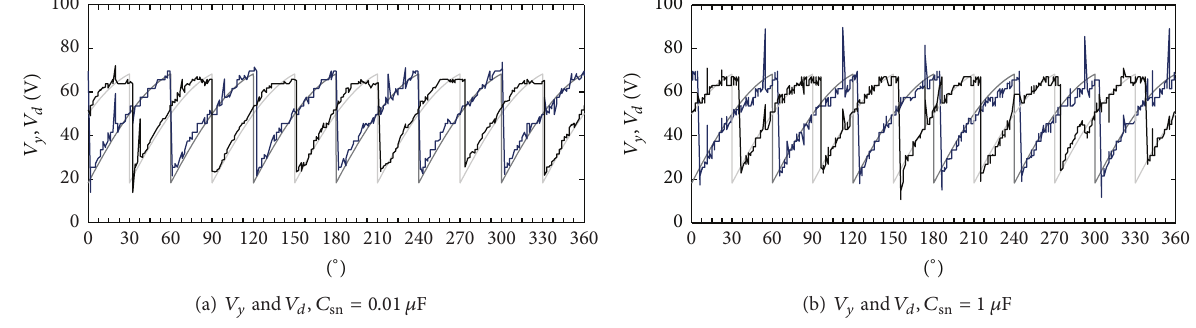
Figure 29: DC voltage waveforms 𝑉 𝑦 and 𝑉 𝑑 .